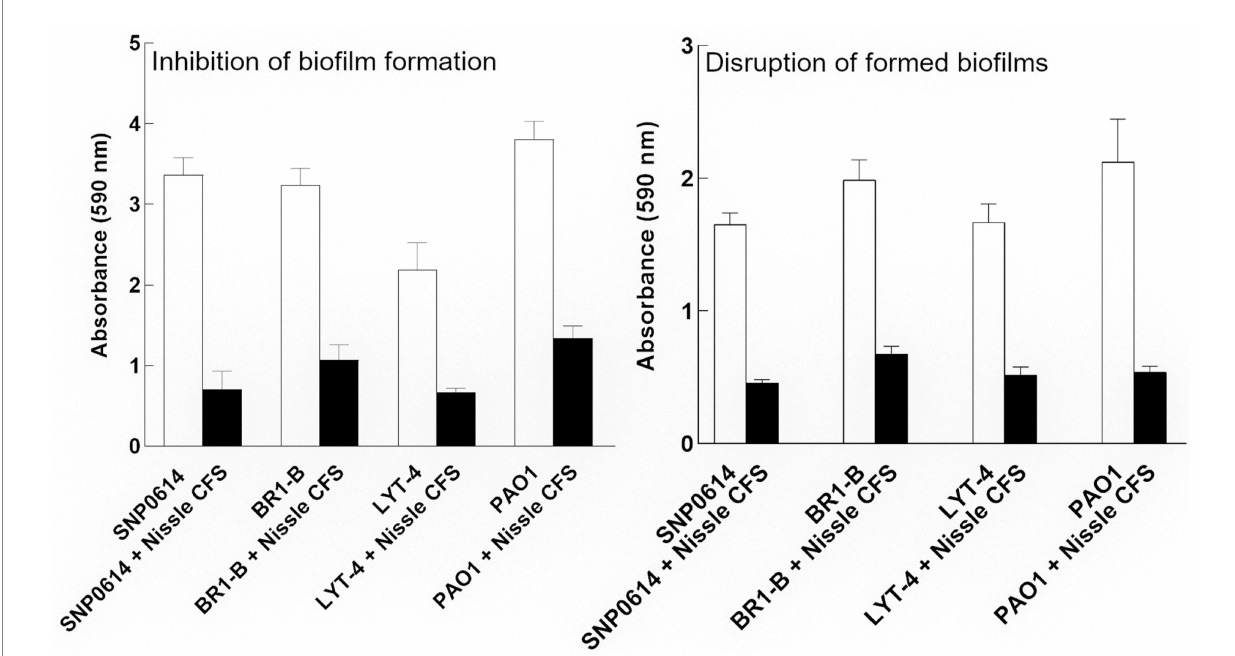
FIGURE 2 Relative biofilm formation of P. aeruginosa (PA) strains grown in the presence of Nissle cell-free supernatant (CFS) measured by crystal violet staining. Nissle cell-free supernatant significantly inhibited biofilm formation and disrupted mature biofilms for all tested P. aeruginosa strains. Data are mean ± SEM., n = 3.